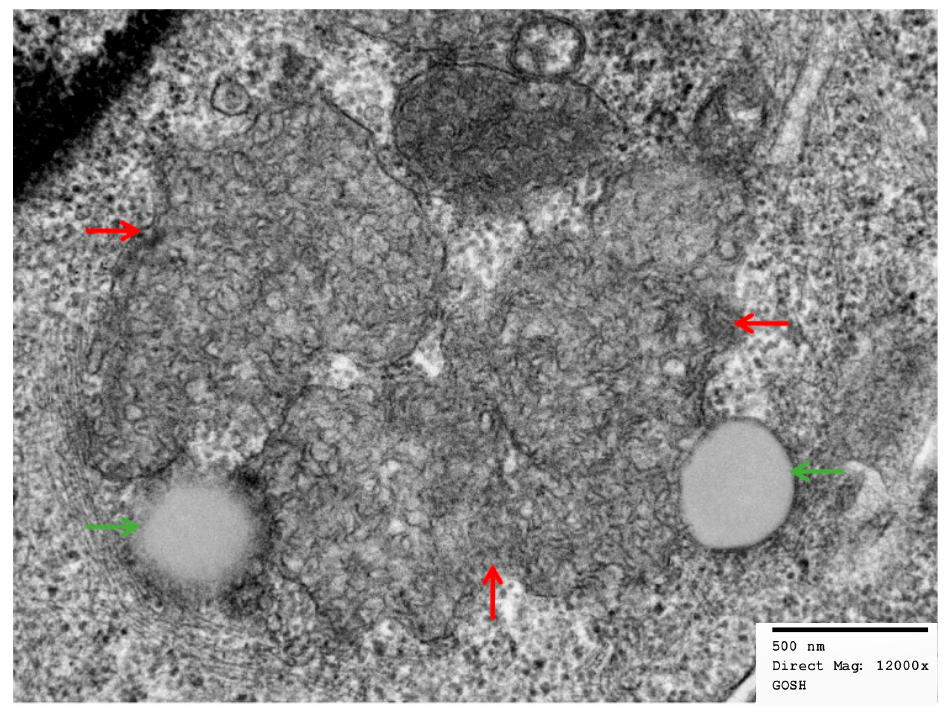
Figure 5. High-power electron micrograph, mag. × 12,000, of membrane-bound storage inclusions in secretory epithelial cells from eccrine sweat gland with curvilinear-like bodies (red arrow) and lipid droplets (green arrow).